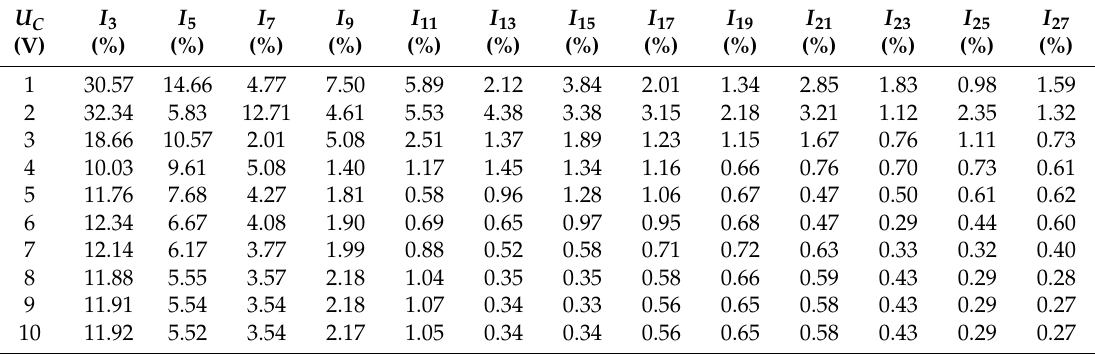
Table 12. List of measured selected RMS values of harmonics I h in relation to the basic harmonics for LED4.